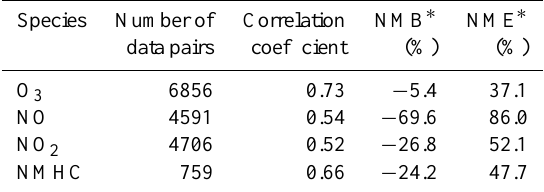
Table 3. CMAQ performance statistics for the simulated hourly concentrations of surface O 3 , NO, NO 2 and NHMC against obser- vations over the PRD during 4–31 October 2004.